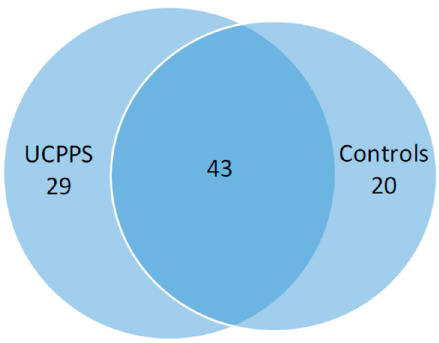
Figure 1. Venn diagram of overlapping species. A total of 92 species were detected with 29 species in IC/BPS only, 20 species in controls only, and 43 in both IC/BPS and controls